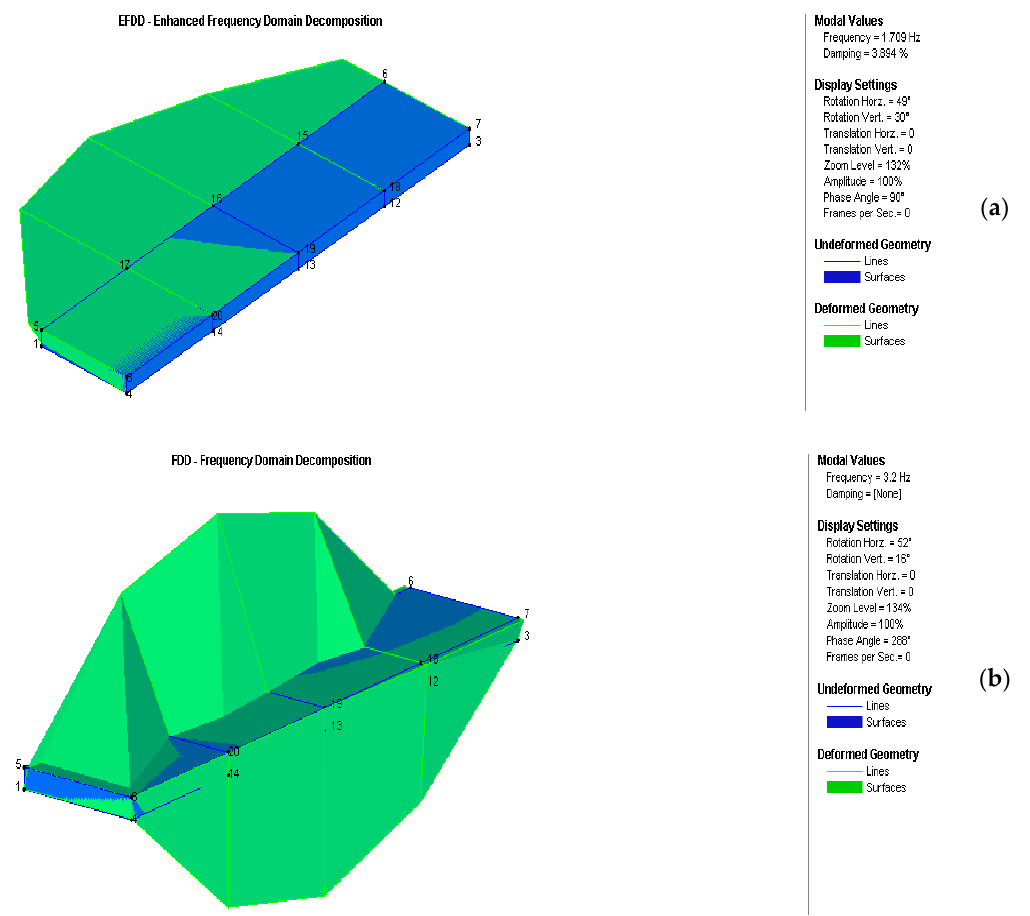
Table 1. Shapes and frequencies of bridge overlay vibrations; values of their suppression